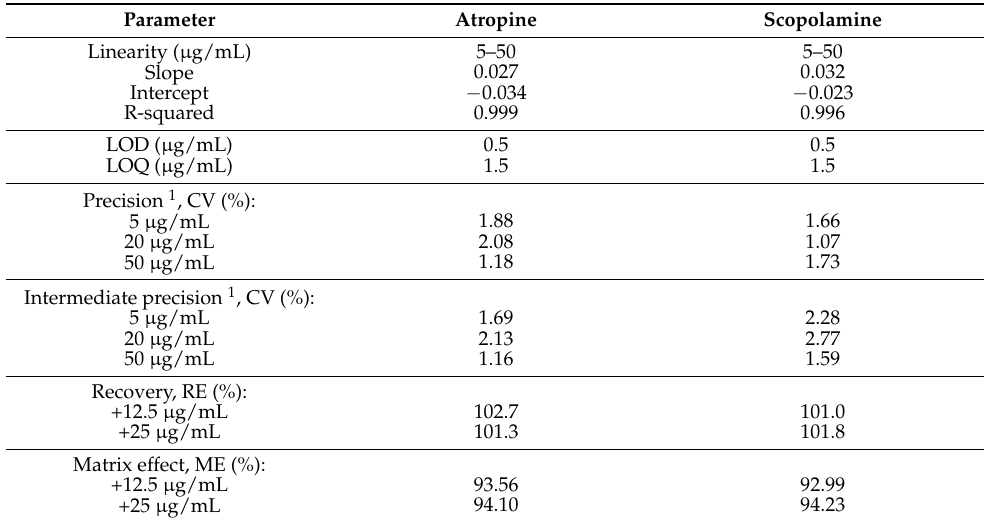
Table 2. Validation parameters for atropine and